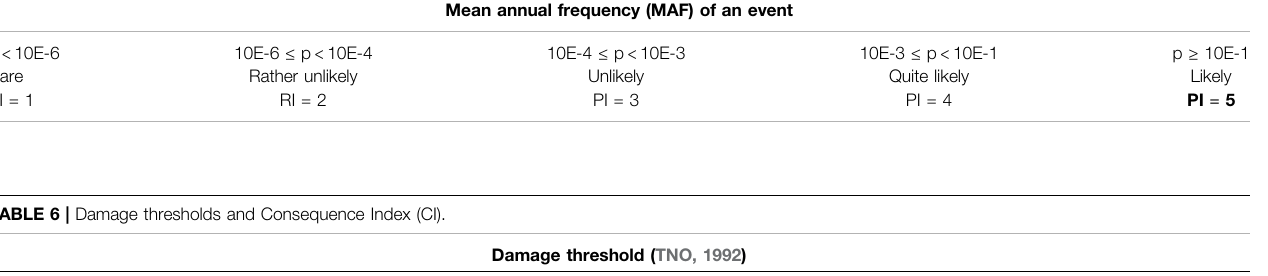
TABLE 5 | Probability classes (PI) (CPS, 1992).